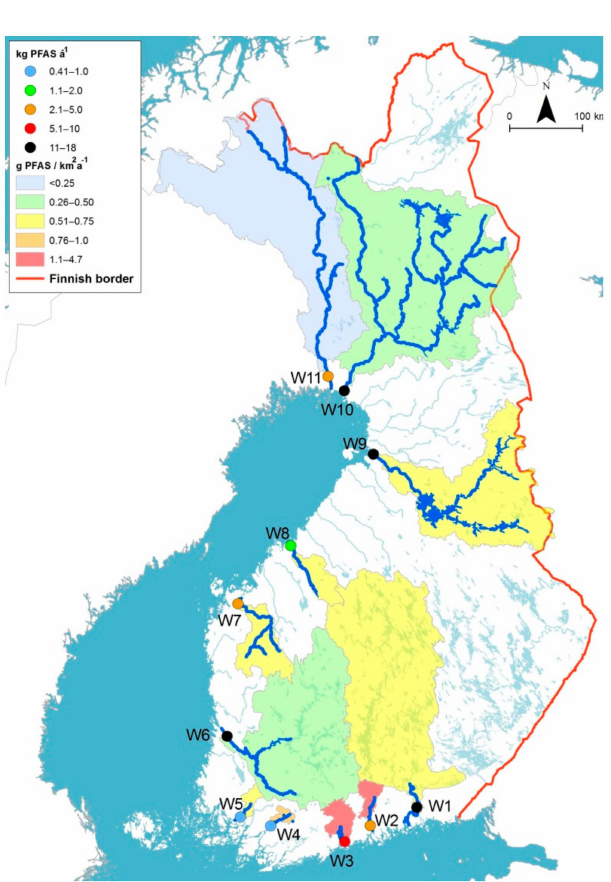
(cid:80) 10 PFASs per area and annual load of